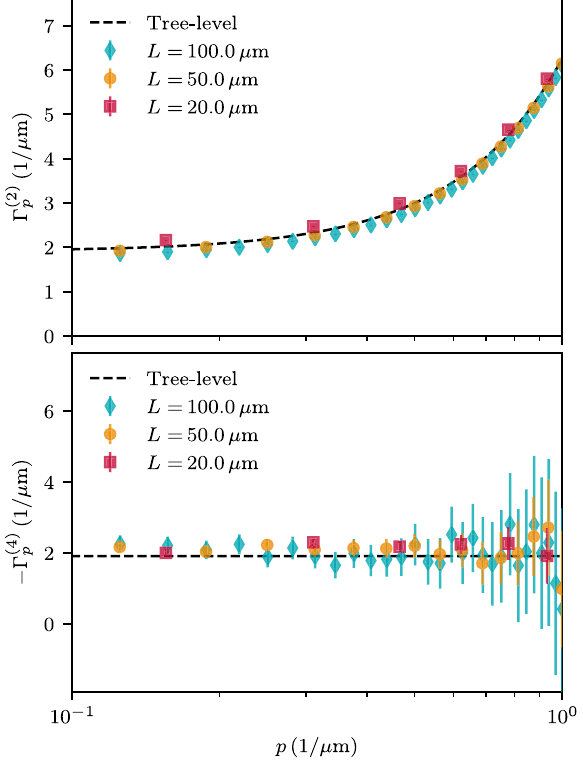
FIG. 3. The 1PI vertices in the weak coupling regime at Q ≈ 11 . 52 calculated from the numerical data for different volumes L ¼ 20 (red squares), 50 (orange circles), and 100 μ m (blue diamonds). The 1PI two-point function (upper) and 1PI four- vertex (lower) show excellent agreement with the tree-level prediction (dashed black line) for a wide range of momenta. The results are obtained from 10 8 samples. The error bars indicate the standard error of the mean.